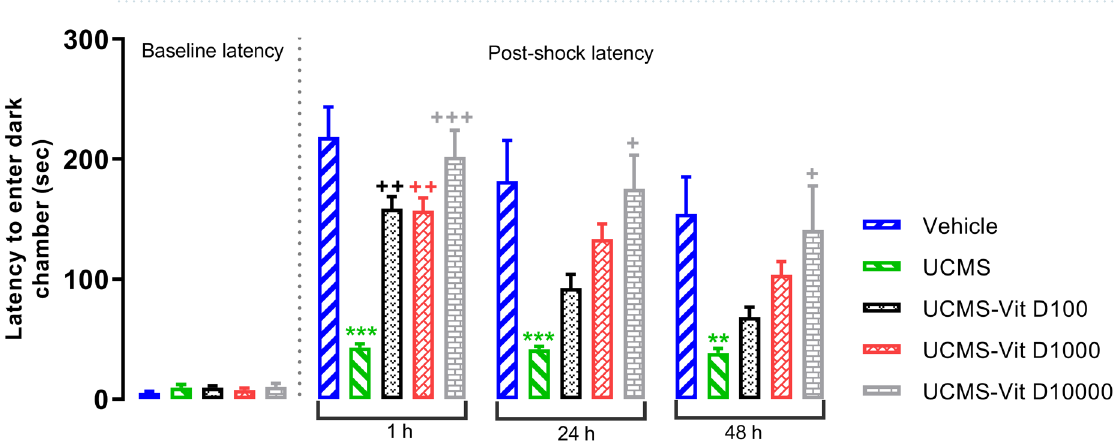
Figure 3. Comparison of latencies to enter dark chamber in UCMS groups. Data are presented as mean ± SEM, n = 10. ** P < 0.01 and *** P < 0.001 versus Vehicle group, + P < 0.05, + + P < 0.01 and + + + P < 0.001 versus UCMS